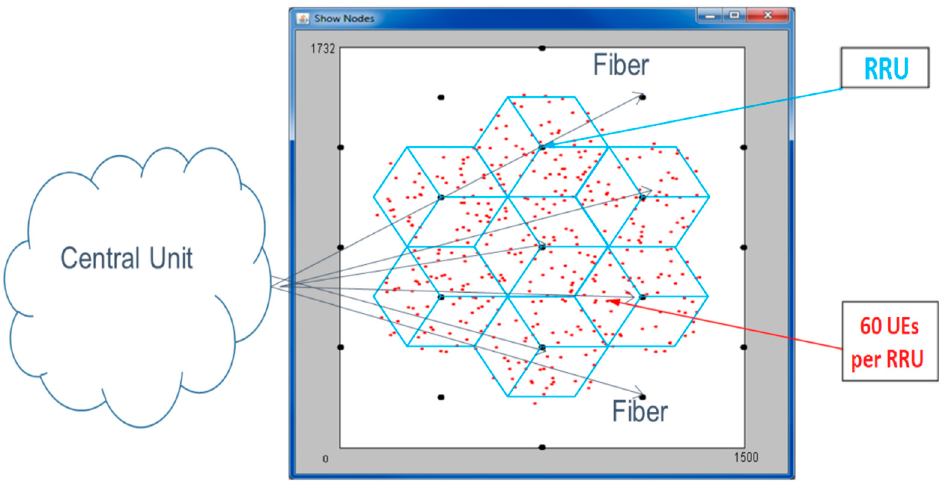
Figure 2. Cloud radio access network (C-RAN) considered for the system level simulations. RRU = Figure2. Cloudradioaccessnetwork(C-RAN)consideredforthesystemlevelsimulations. RRU = radio radio remote unit. remote